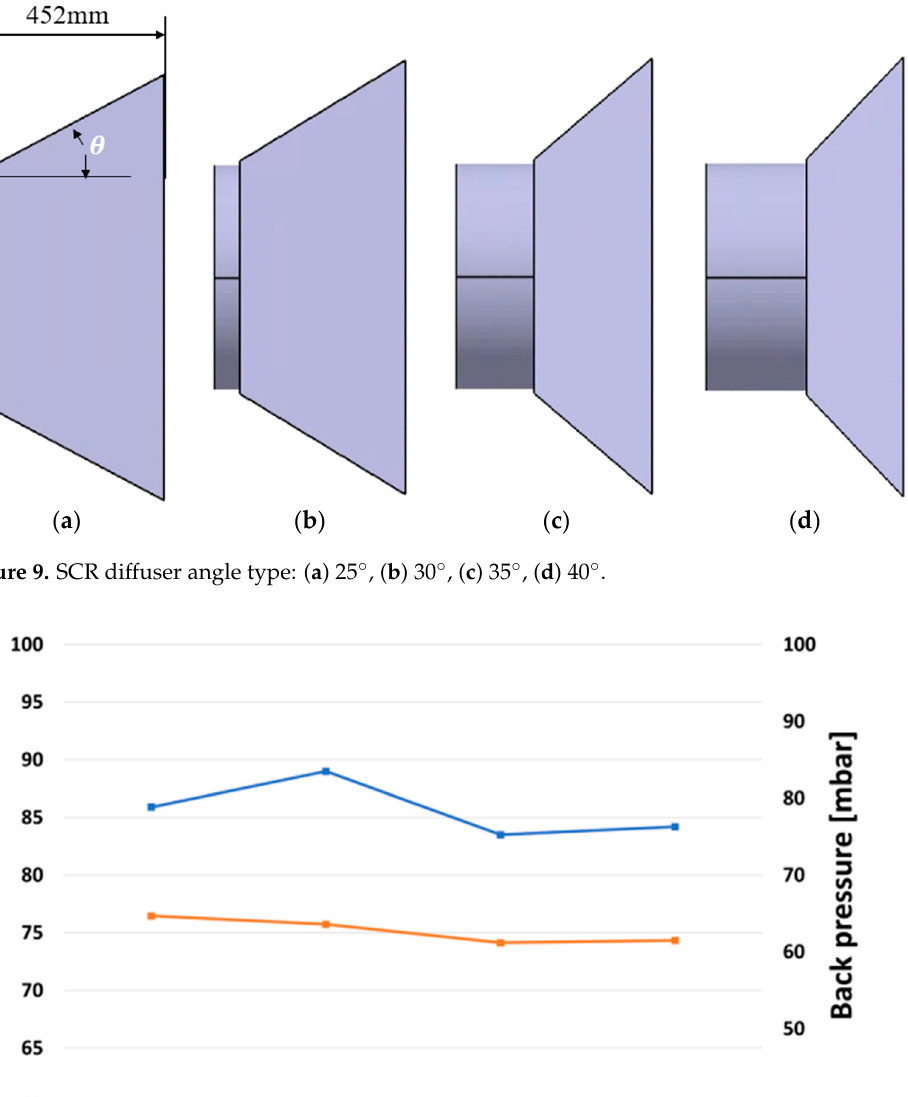
Figure 10. Correlation between uniformity, back pressure, and diffuser angle.